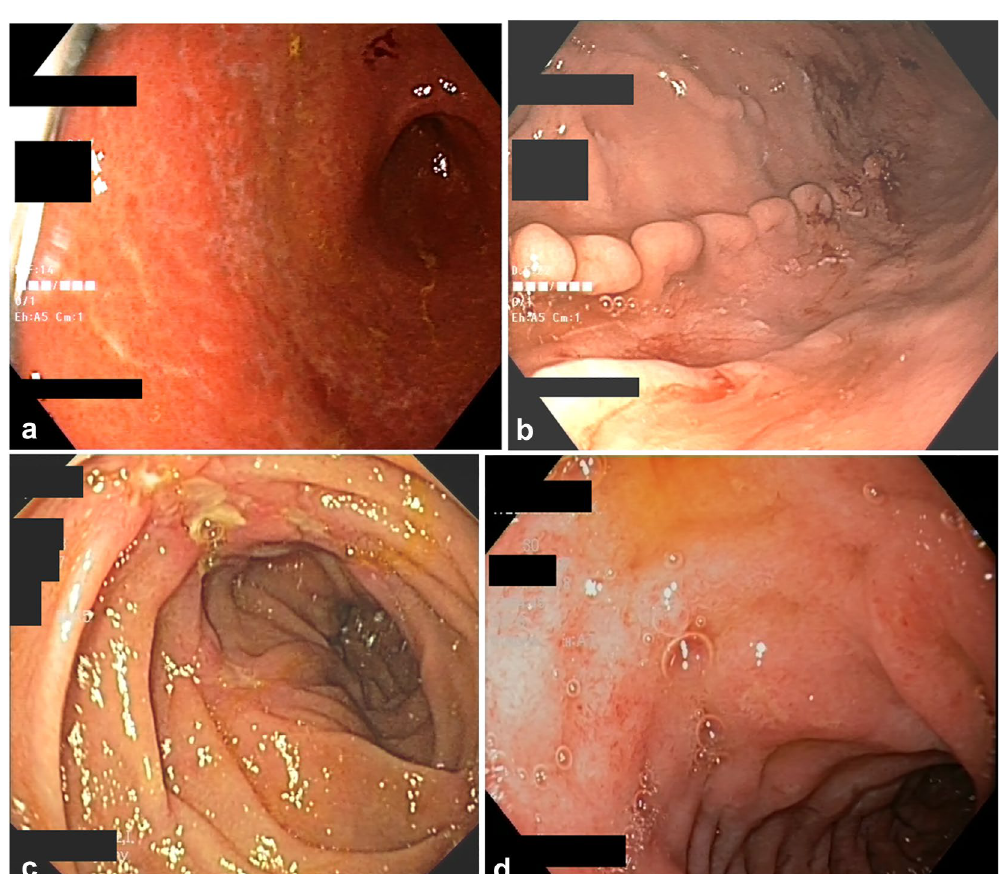
Figure 2. Representative images of certain significant endoscopic findings within the upper gastrointestinal tract in patients with Crohn’s disease. ( a ) gastric mucosal inflammation, ( b ) bamboo joint-like appearance of the stomach, ( c ) ulcerations in descending part of duodenum, ( d ) duodenal mucosal inflammation and